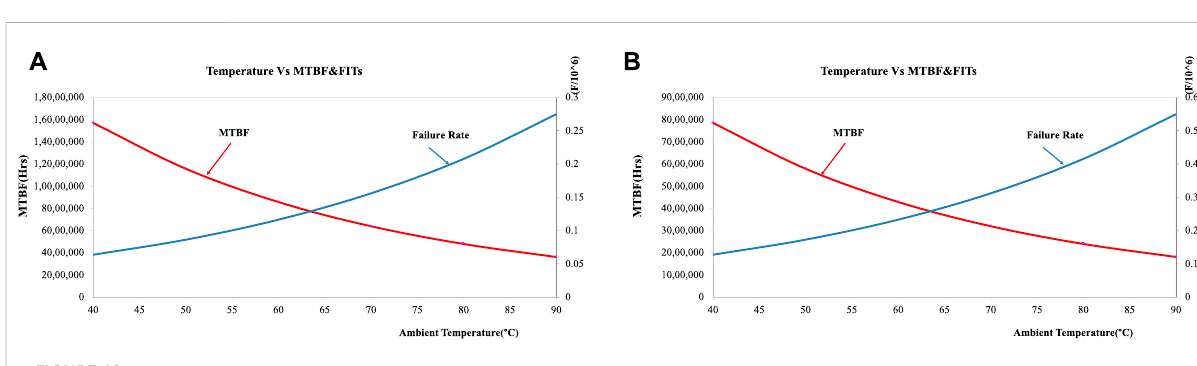
FIGURE 12 Failure rate and MTBF of LLC converter at (A) Ground, fi xed, and controlled (B) . Ground, Fixed, and